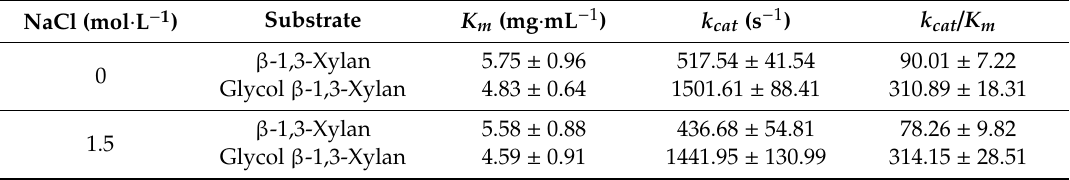
Table 2. The kinetic parameters of Xyl88 for the hydrolysis of soluble and insoluble β